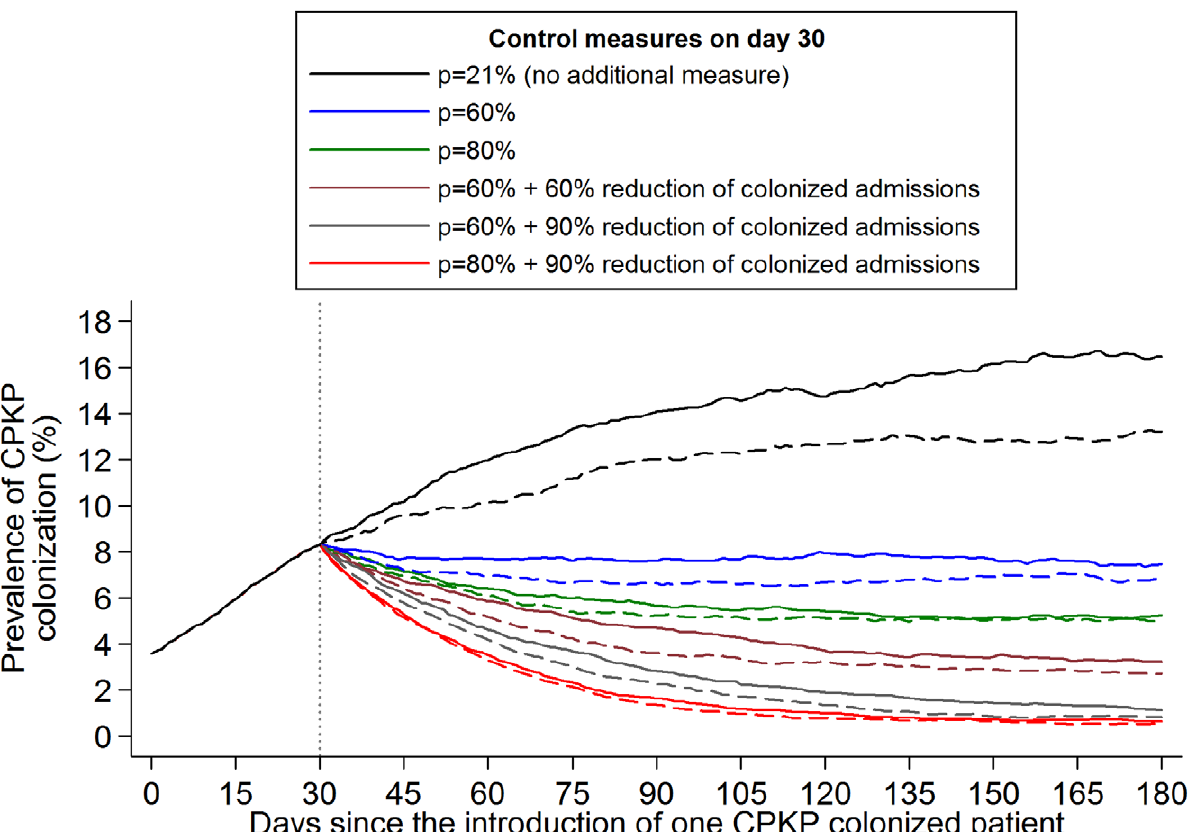
Figure 4. Impact of infection control measures on the prevalence of CPKP colonization in an endemic setting. One CPKP colonized patient enters the surgical unit on day 0 and the only infection control measure applied during the first 30 days is hand hygiene compliance ( p =21%). The impact of various infection control strategies implemented since day 30 on CPKP colonization prevalence was simulated (the mean of 1,000 simulations is shown). The evaluated scenarios include: 1. adopt no additional infection control measures (hand hygiene compliance p =21%), 2. increase p to 60%, 3. increase p to 80%, 4. increase p to 60% and reduce colonization prevalence on admission of CPKP by 60% (through active surveillance and subsequent isolation or strict contact precautions for positive patients), 5. increase p to 60% and reduce colonization prevalence on admission of CPKP by 90%, 6. increase p to 80% and reduce colonization prevalence on admission of CPKP by 90%. Dashed lines ( - - - ) correspond to the above scenarios with the addition of 50% reduction in the duration of antibiotic usage during patients’ stay in the unit (assuming a relative risk associated with antibiotic use equal to 3).